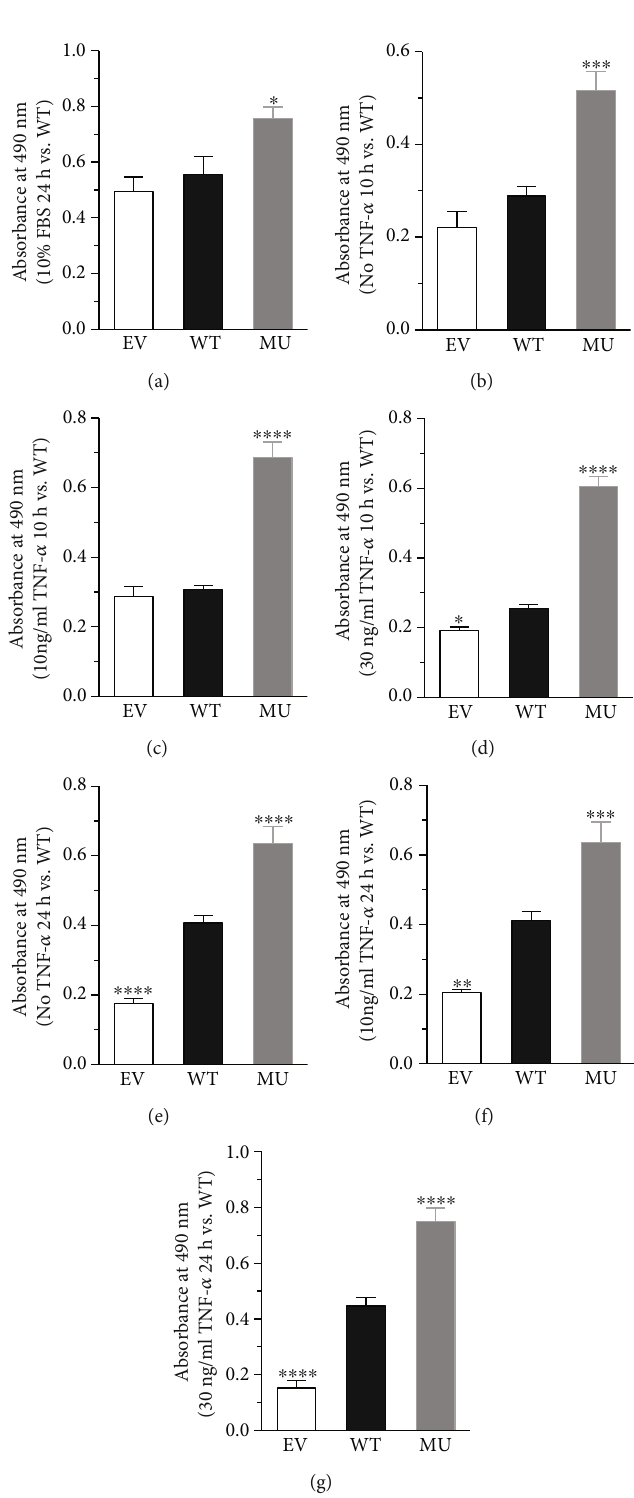
Figure 2: Deletion of GATA4 C-terminus enhanced RCSMC proliferation. The e ff ects of GATA4 WT and MU overexpression on RCSMC proliferation was detected by MTS. The cells were treated with (a) 10% FBS for 24 h, (b – d) TNF- α (10 or 30 ng/ml) for 10 h, and (e – g) TNF- α (10 or 30ng/ml) for 24h. One-way ANOVA, ∗ P < 0 : 05 , ∗∗∗ P < 0 : 001 , ∗∗∗∗ P < 0 : 0001 versus WT, n = 3